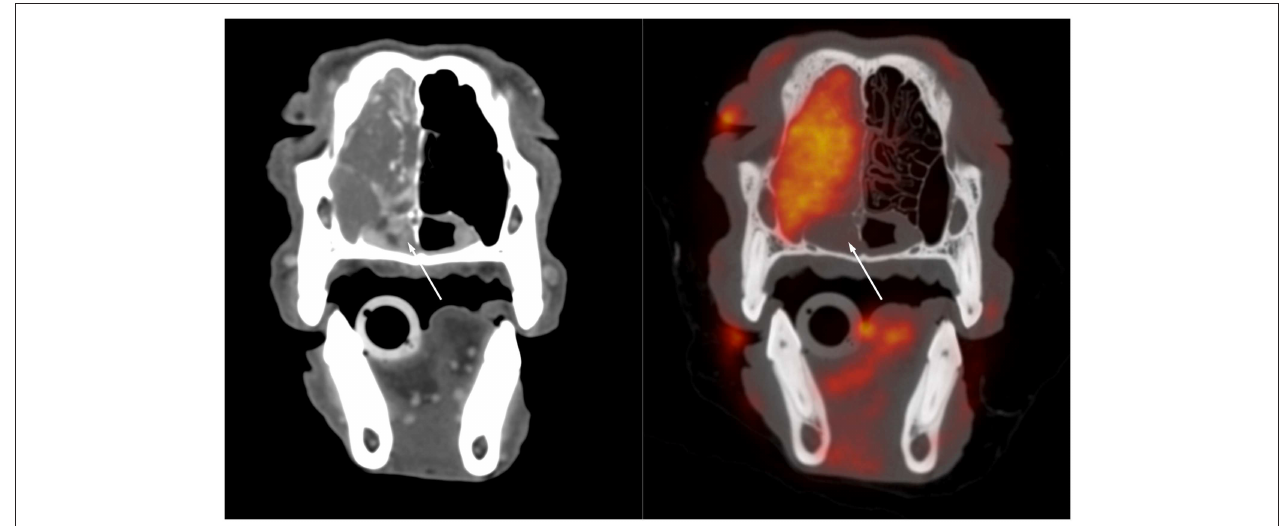
FIGURE 1 | Transverse post-contrast CT (left) and fused 18F-FDG PET/CT (right) images through the caudal aspect of the nasal cavity of a 10-year-old male castrated standard poodle presented for staging of nasal adenocarcinoma. There is a large soft tissue mass filling the left side of the nasal cavity and resulting in destruction of the nasal turbinates and invasion of the maxillary recess. The soft tissue opacity extends ventrally into the rostral aspect of the nasopharynx. The opacity in the nasopharynx is strongly contrast enhancing on the CT image but does not show FDG uptake whereas the rest of the mass demonstrates strong FDG uptake. This suggests that the tissue in the nasopharynx differs from the bulk of the tumor and might represent edematous nasopharyngeal mucosa rather than neoplastic